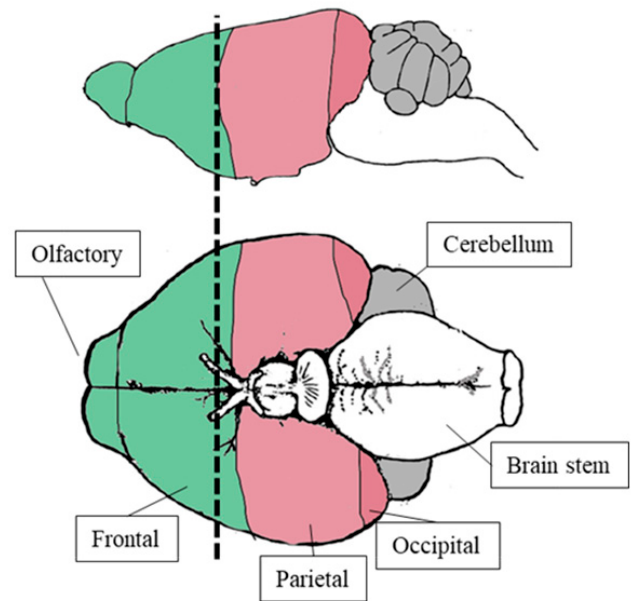
Figure 7. Anterior (green) and posterior (pink) brain cortex partition. As displayed, the brain was cut just in front of the optic chiasm. Consequently, the “anterior segment” mostly included frontal and olfactory cortex, while the posterior one mainly encompassed parietal–temporal and occipital lobes with the possible contamination of a small fraction of the midbrain.